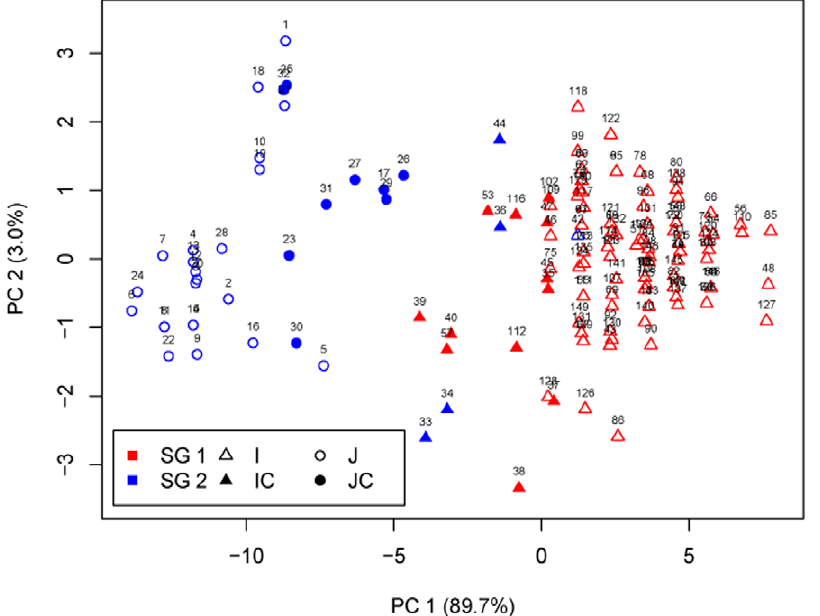
Figure 3. Principal component analysis on the six phenotypic traits of Cheng ’ s index as well as Cheng’s index of the entire population. PC 1 and PC 2 refer to the first and second principal components, respectively. The numbers in parentheses refer to the proportion of variance explained by the corresponding axes. Symbols identify the germplasm types and colors the MCLUST subgroups. SG 1 and SG 2 are the two subgroups identified by MCLUST on the six phenotypic traits of Cheng’s index as well as Cheng’s index. I, IC, J, JC are indica , indica -clined, japonica , japonica -clined rice.